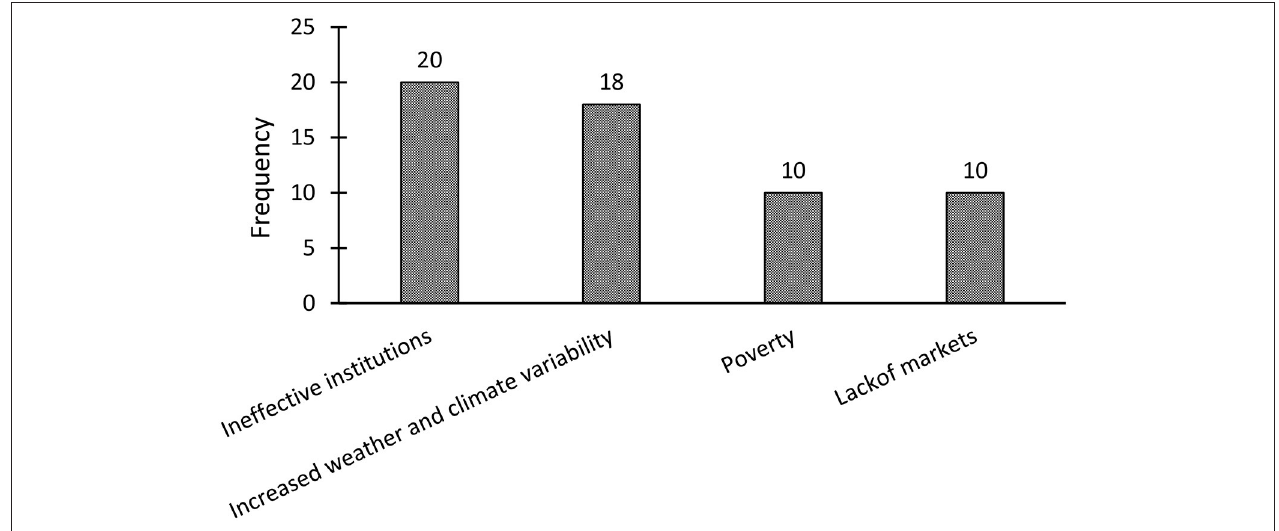
FIGURE 5 | Challenges faced by Farmers (multiple response) n =